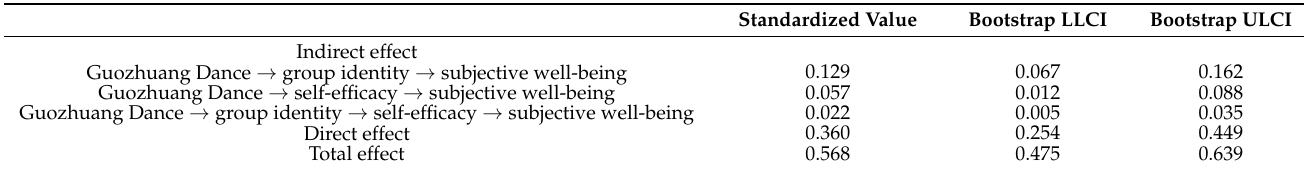
Table 6. Mediating effect